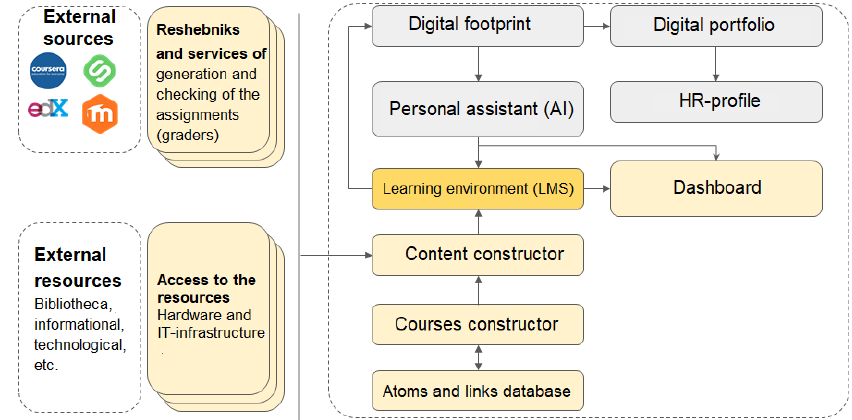
Fig. 1. The general structure of the digital educational